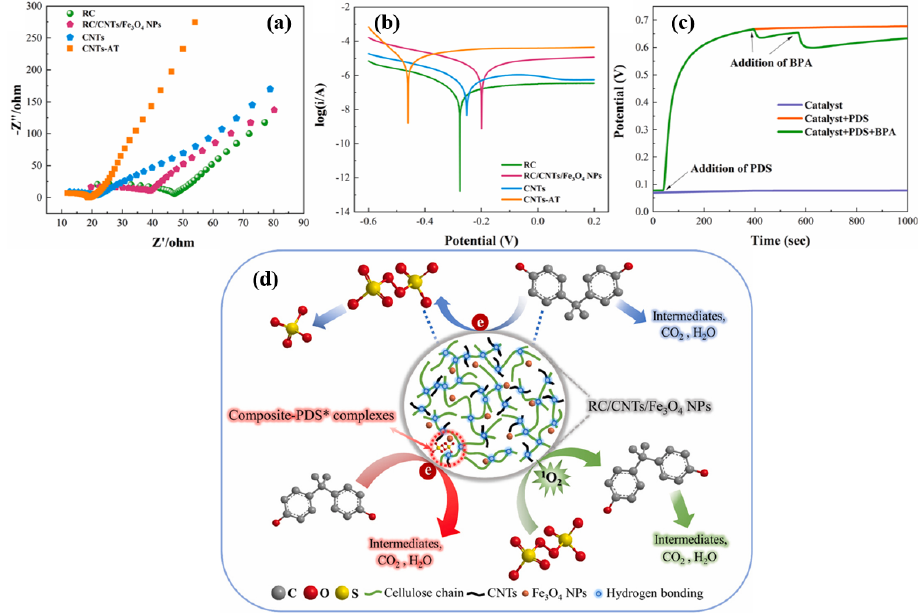
Figure 4. Electrochemical impedance spectroscopy. ( a ) Tafel polarization curve; ( b ) the open circuit potential curve ( c ) and schematic diagram of the mechanism ( d ) of the BPA removal in the RC/CNTs/Fe 3 O 4 /PDS system [55].